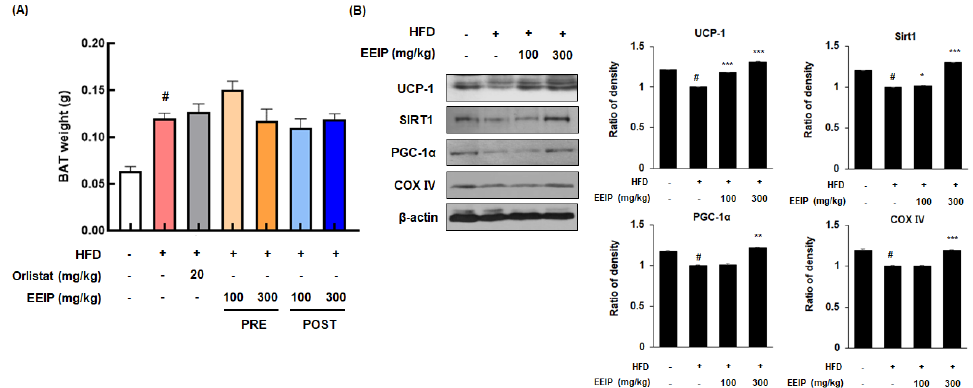
Figure 8. Effect of EEIP pre − administration on thermogenic factors in the brown adipose tissue (BAT) of HFD − fed obese mice ( A ) The brown adipose tissue weight of HFD − fed obese mice. ( B ) The protein expression levels of thermogenesis factors involving UCP − 1, SIRT1, PGC − 1 α , and COX IV were determined by Western blotting analysis and β − actin was used as an internal control. Densitometric analysis was performed using Bio − Rad Quantity One Software (BioRad; Hercules, CA, USA). Values are represented as the mean ± SEM. # p < 0.05 vs. normal diet control group; * p < 0.05, ** p < 0.01, and *** p < 0.001 vs. HFD group.